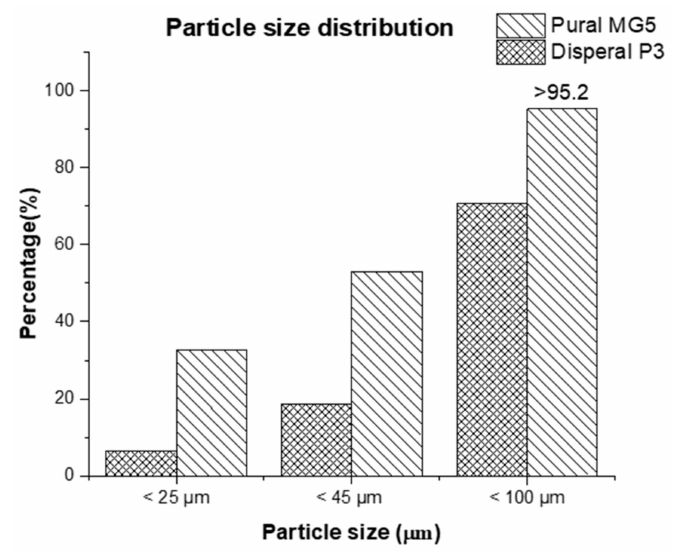
Figure 1. Particle size distribution of Disperal P3 and Pural